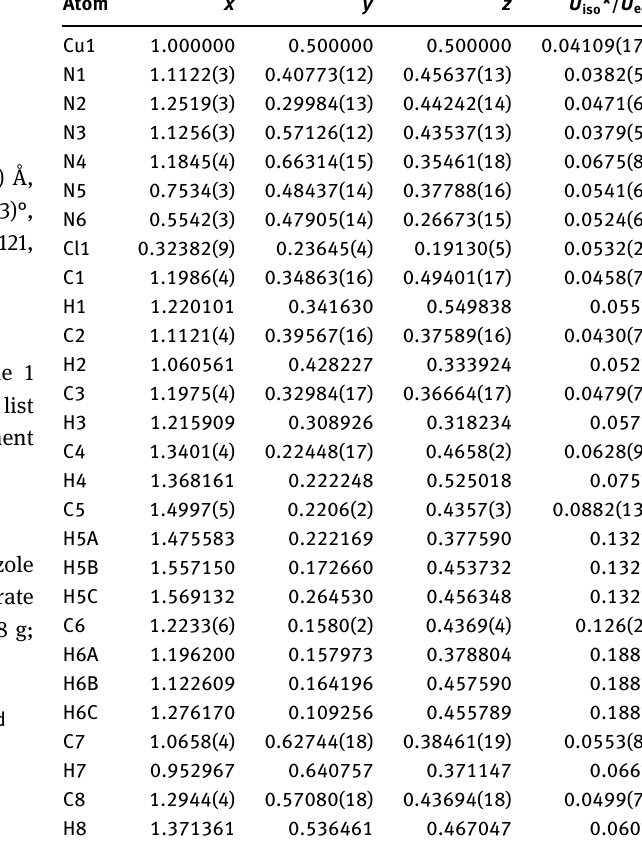
Table 2: Fractional atomic coordinates and isotropic or equivalent isotropic displacement parameters (Å 2